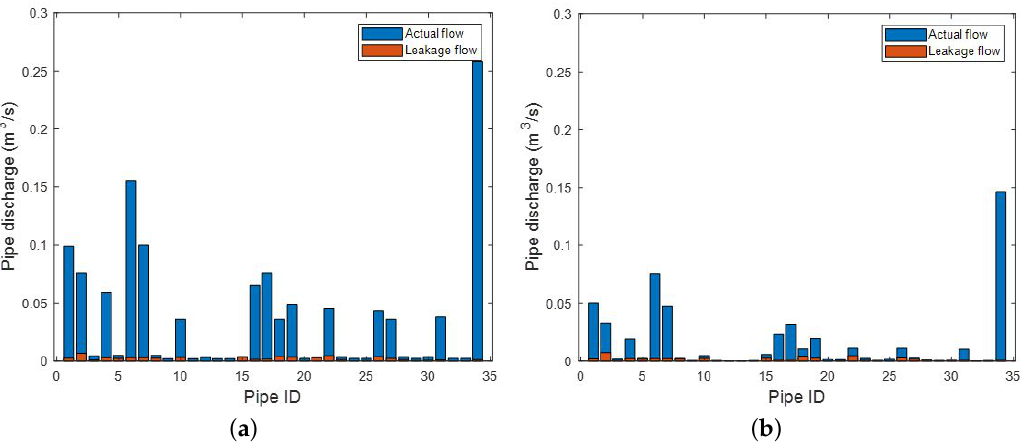
Figure 6. The pipe discharge and the leakage flow for the case study network 2: ( a ) DDM analysis; ( b ) PDM